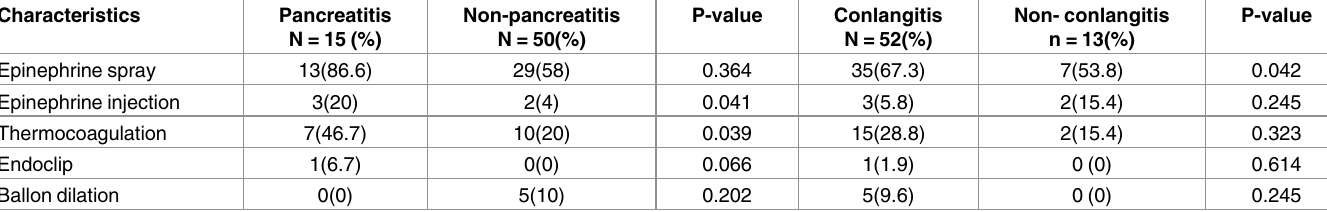
Table 3. Comparison of complication between the different hemostatic